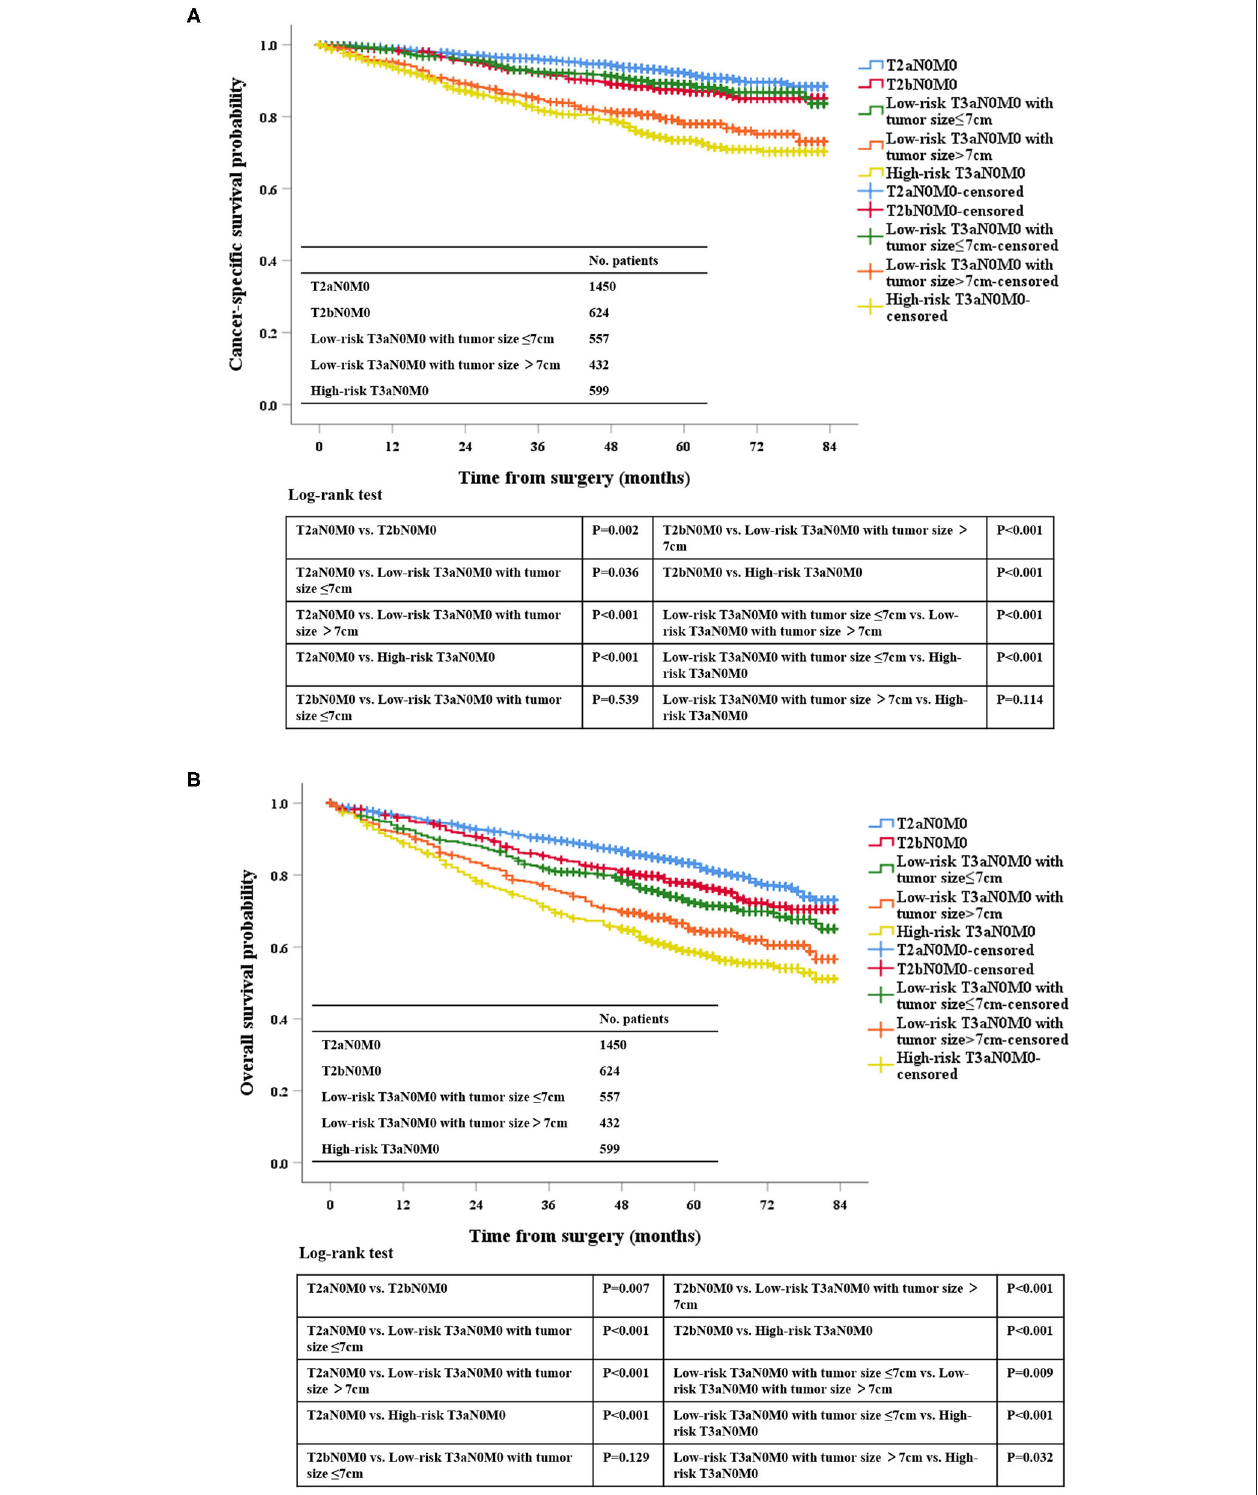
FIGURE 2 | Kaplan-Meier analysis of the survival of low-risk pT3aN0M0 RCC patients after radical surgery stratified by tumor size with a cut-off of 7cm in all cohorts for CSS (A) and OS (B) .